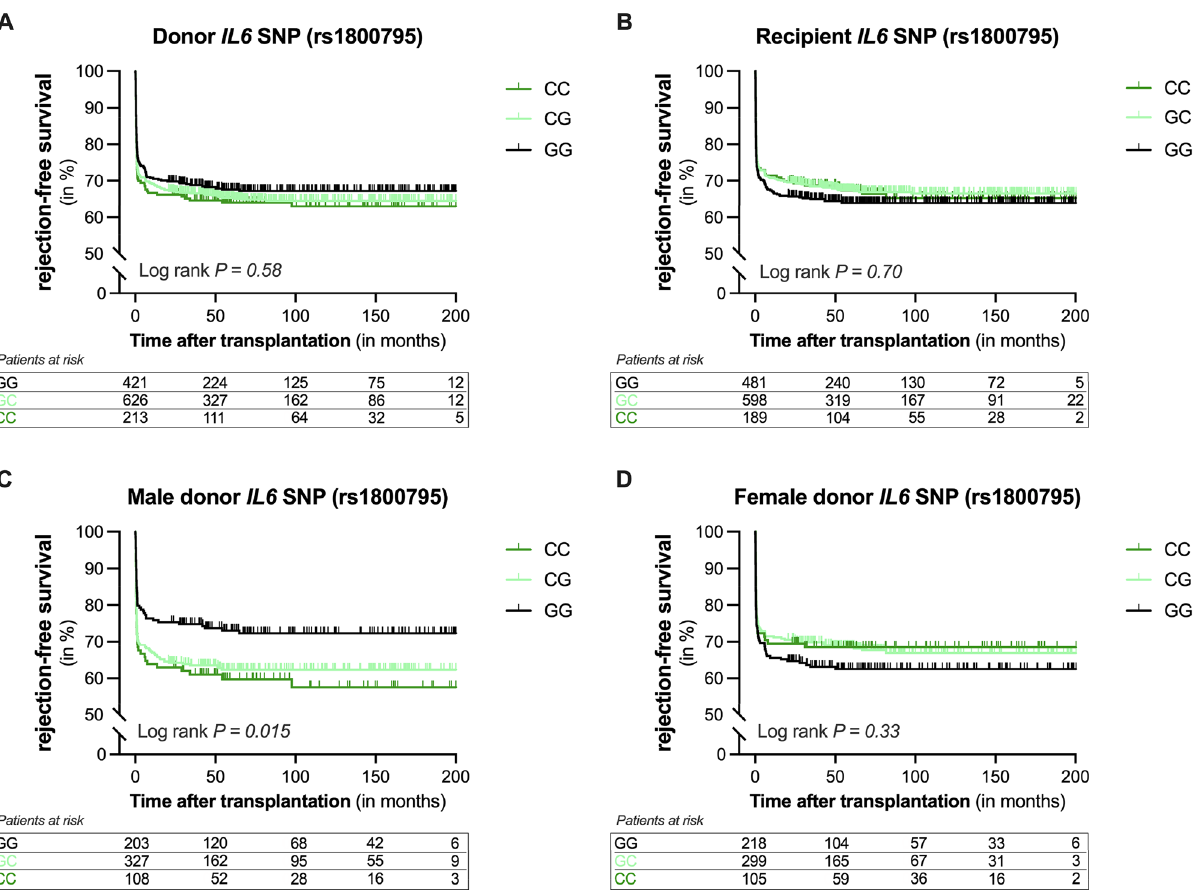
Figure 3. Kaplan–Meier curves for rejection-free survival of kidney allografts according to the presence of the interleukin-6 genetic variant in the donor or recipient. Cumulative rejection-free survival of renal allografts according to the presence of the interleukin-6 polymorphism ( IL6 ) at position-174 in the promoter (rs1800795 G > C) in ( A ) the donor and ( B ) the recipient. A subgroup analysis was performed for donor sex and cumulative rejection-free survival was shown according to the presence of the IL6 SNP in ( C ) male donors and ( D ) female donors. Log-rank test was used to compare the incidence of biopsy-proven rejection between the